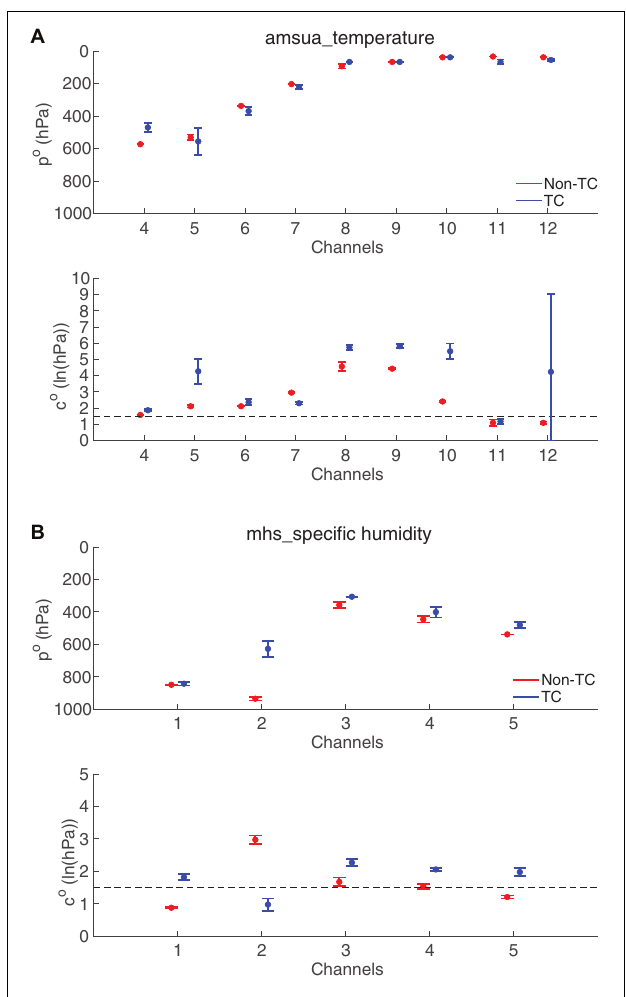
FIGURE 4 | Same as Figure 2 for (A) AMSU-A and (B) MHS radiance observations, but with blue (red) denotes TC (non-TC) regions.